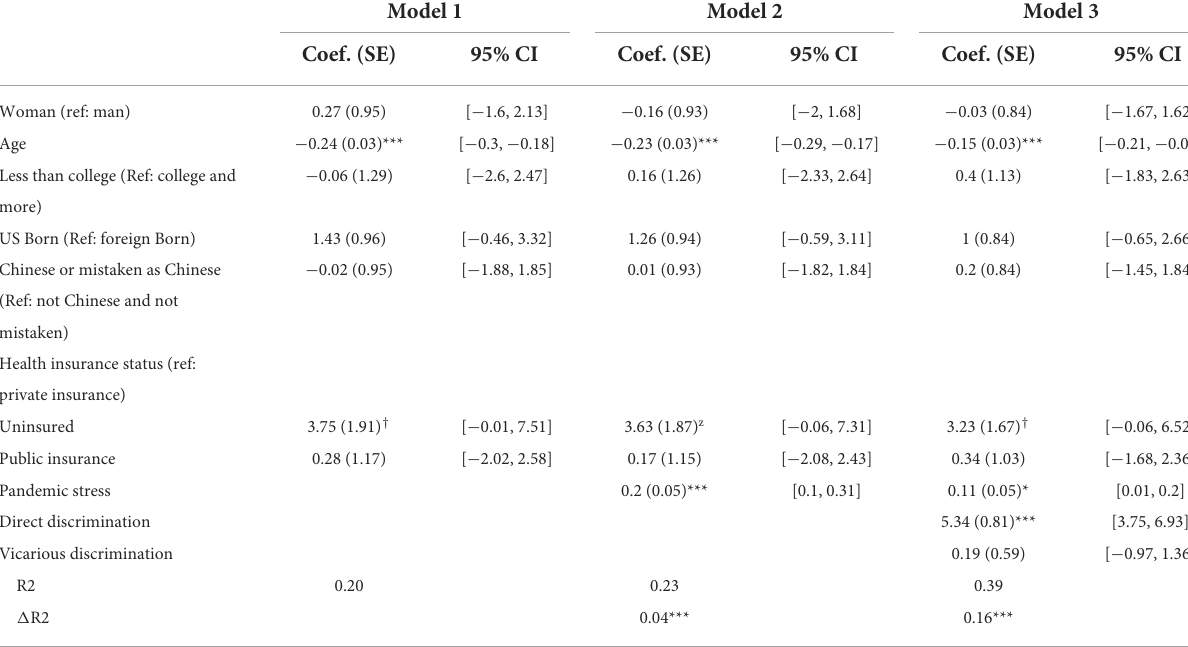
TABLE 4 Hierarchical regressions for psychological distress: East